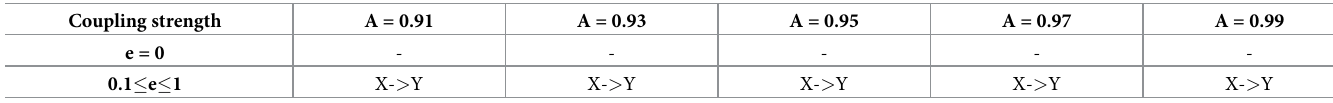
This table shows the directional inference of the cosine map by using WM at different stopping criteria A and coupling strength e. Since the cosine map is bivariate, the WM and WPM have the same results on this